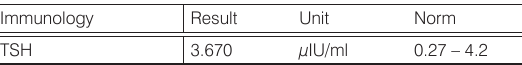
Table 3. Results of the laboratory tests –